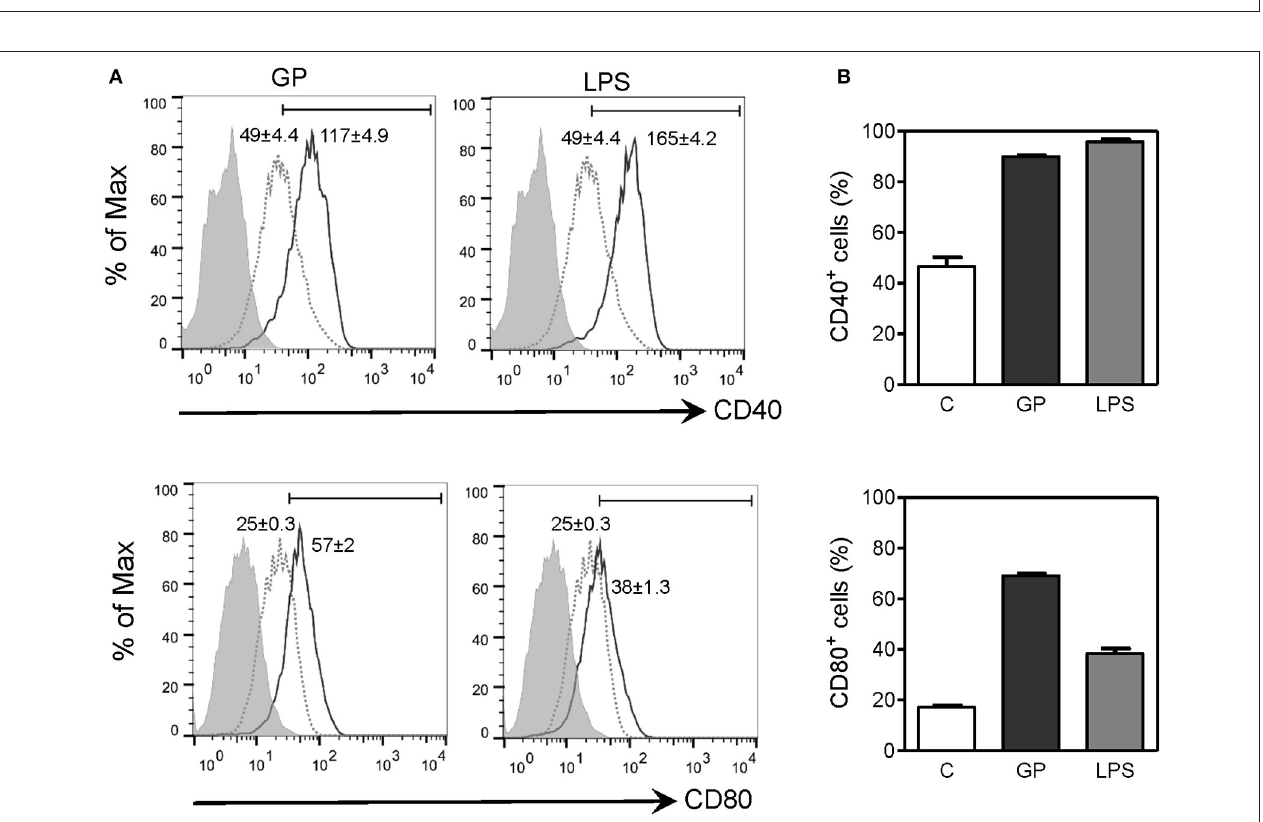
FIGURE 7 | EBOV GP induces the phenotypic maturation of mouse BMDMs. BMDMs from C57BL/6 mice were exposed to 10 µ g/mL EBOV GP or 100 ng/mL LPS for 2 days. The cells were washed and stained with fluorochrome-conjugated anti-CD40 and CD80 antibodies, and the surface expression of costimulatory molecules was assessed by flow cytometry. (A) One representative is presented in single parameter histograms (gray dotted line: control; black solid line: GP or LPS; gray shade: FMO). MFI (mean fluorescence intensity) values are shown as mean ± SEM of two independent experiments in flow cytometry profiles. Positive cells exhibit a MFI greater than the value of FMO. (B) The percentages of CD40 + and CD80 + cells are expressed as mean ± SEM of duplicate measurements in bar